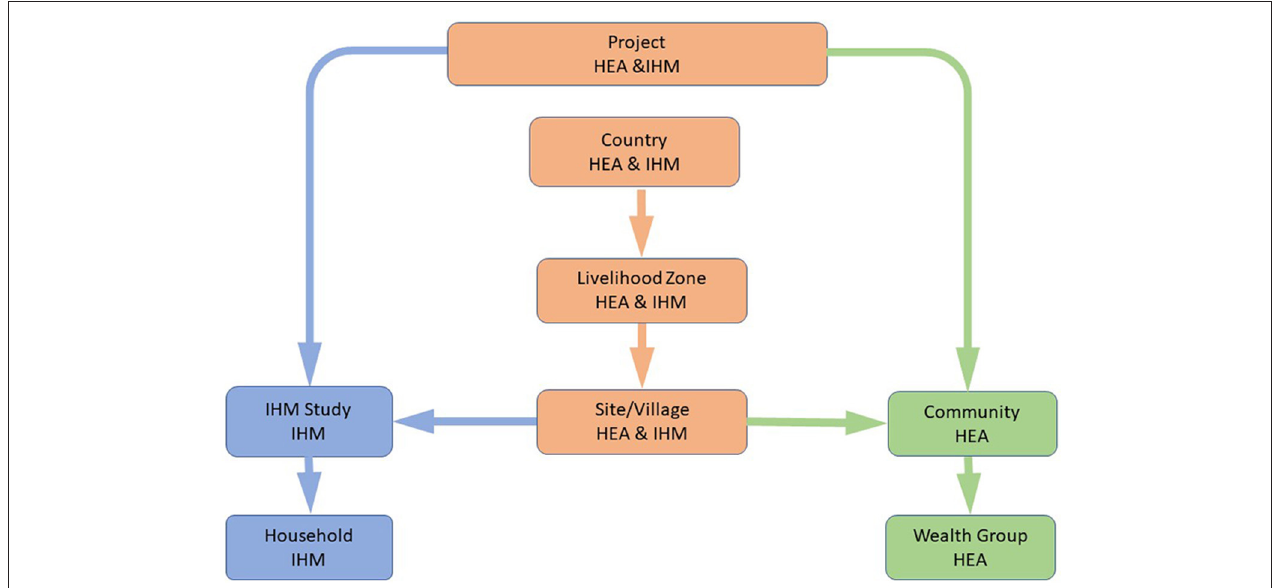
FIGURE 1 | The HEA and IHM: levels of data collection. Source: own elaboration based on images with “no copyright reserved” (Creative Commons Attribution Non Commercial No Derivatives 4.0 International